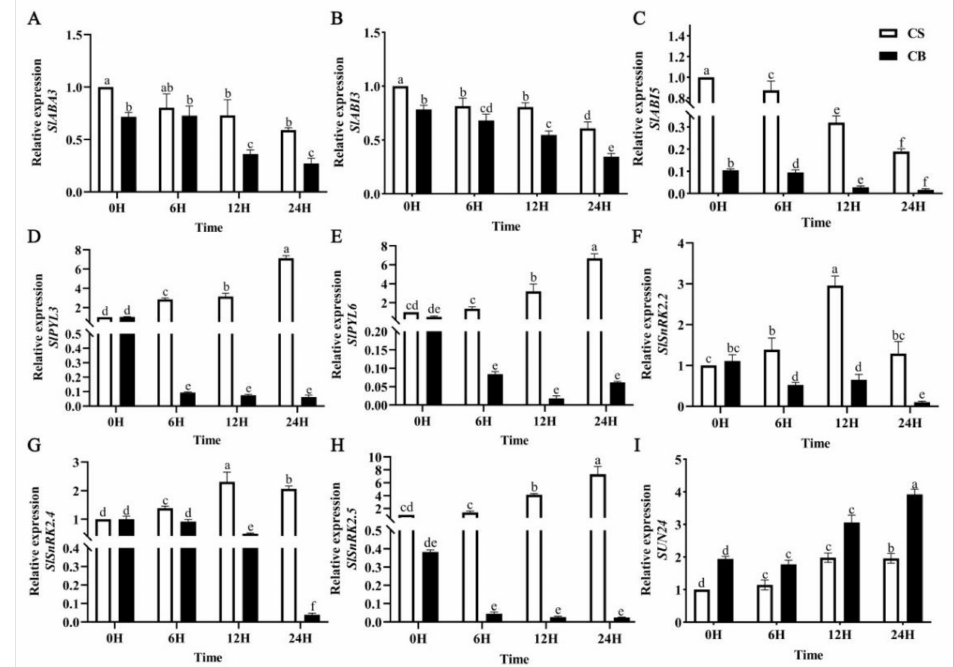
Figure 6. Effects of betaine pretreatment on the expression levels of key genes in ABA signal transduction. The content of abscisic acid in the neutrons of tomatoes under low-temperature stress was determined by qRT-PCR. ( A ) SlABA3 , ( B ) SlABI3 , ( C ) SlABI5 , ( D ) SlPLY3 , ( E ) SlPLY6 , ( F ) SlSnRK2.2 , ( G ) SlSnRK2.4 , ( H ) SlSnRK2.5 , ( I ) SUN24 . Vertical bars indicate the mean ± SEs calculated for three replications. CS: germination of seeds pretreated with just water under 14 ◦ C cold stress; CB: germination of seeds pretreated in 10 mmol/L of GB under 14 ◦ C cold stress. Different lowercase letters indicate significant differences at the 0.05 probability level ( p <